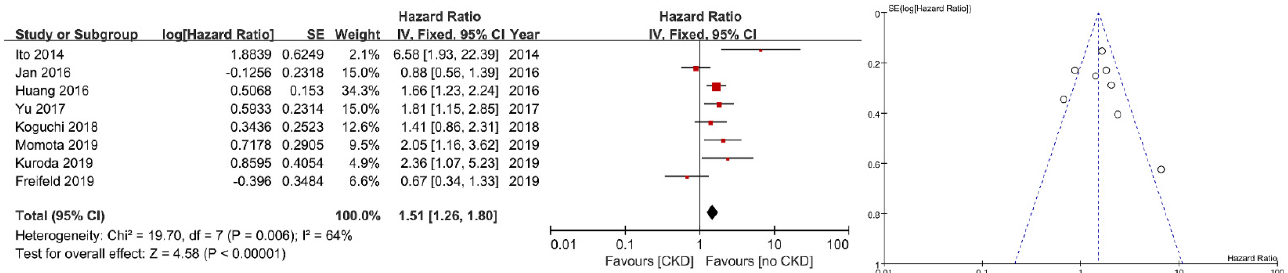
Figure 2. Forest plot and funnel plot of progression-free survival after radical nephroureterectomy according to preope-ative renal function. SE: standard error; IV: inverse variance; CI: confidence interval; df: degree of freedom.